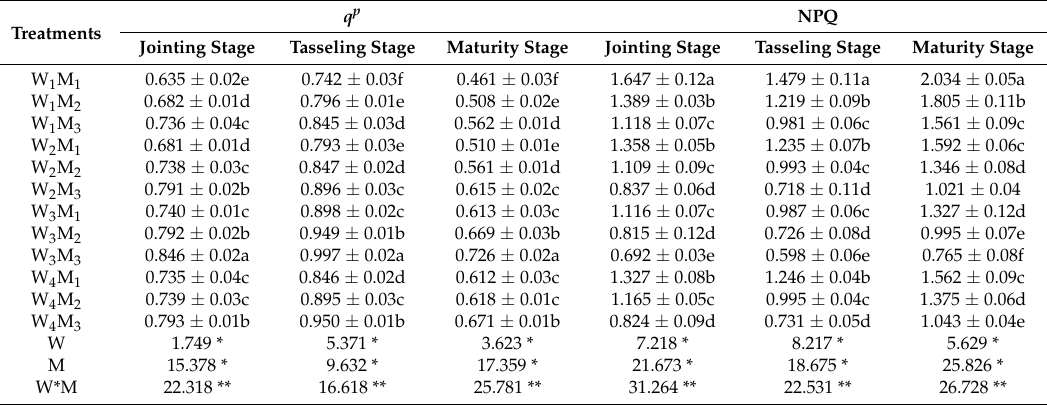
Table 5. Effect of irrigation amount on q p and NPQ of degradable film-covered drip-irrigated maize. q p NPQ Treatments Jointing Stage Tasseling Stage Maturity Stage Jointing Stage Tasseling